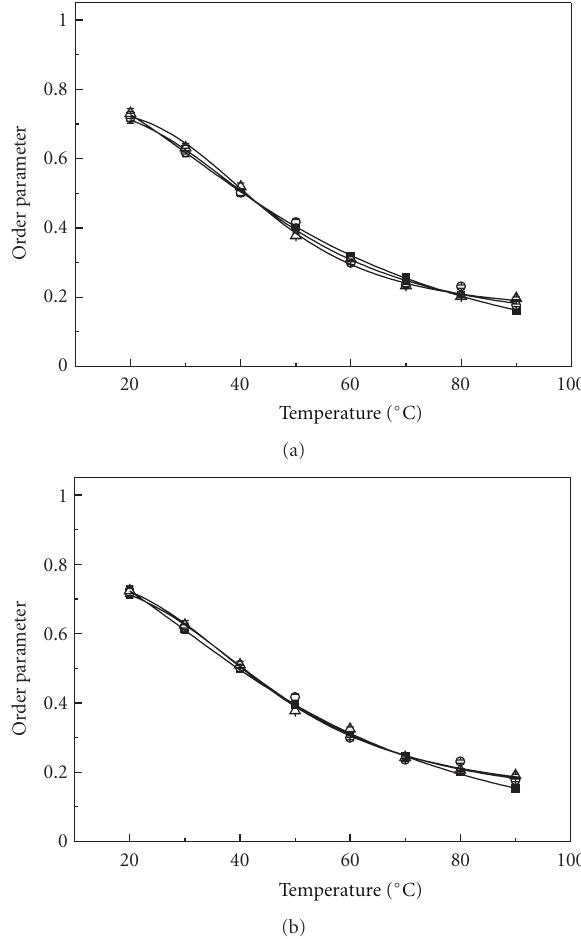
Figure 4: Temperature dependence of the lipid-order parameter of the PLMF from A. pernix grown in medium with di ff erent pH ( (cid:2) pH 6.0; (cid:6) pH 7.0; Δ pH 8.0) determined by measuring the anisotropy of DPH. The lines represent nonlinear curve fitting to the data points. (a) pH of measured samples was the same as the pH of growth medium; (b) experiments were performed at pH